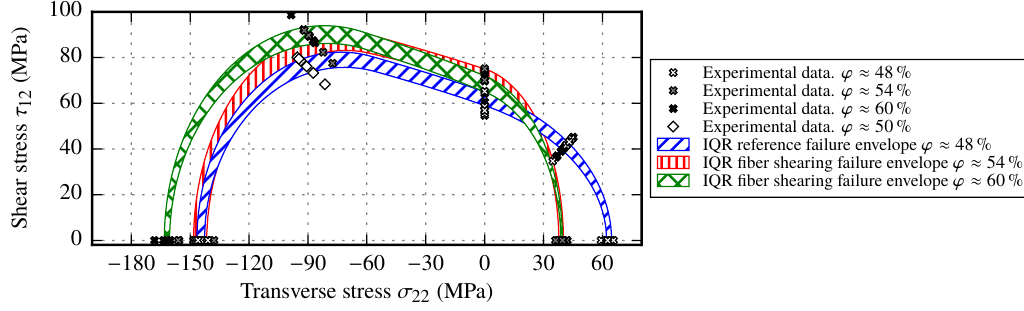
Figure 23. Failure envelope ranges for samples with an imposed fiber shearing at ϕ ≈ { 54%,60% } in comparison to the reference samples envelope at ϕ ≈ 48%.